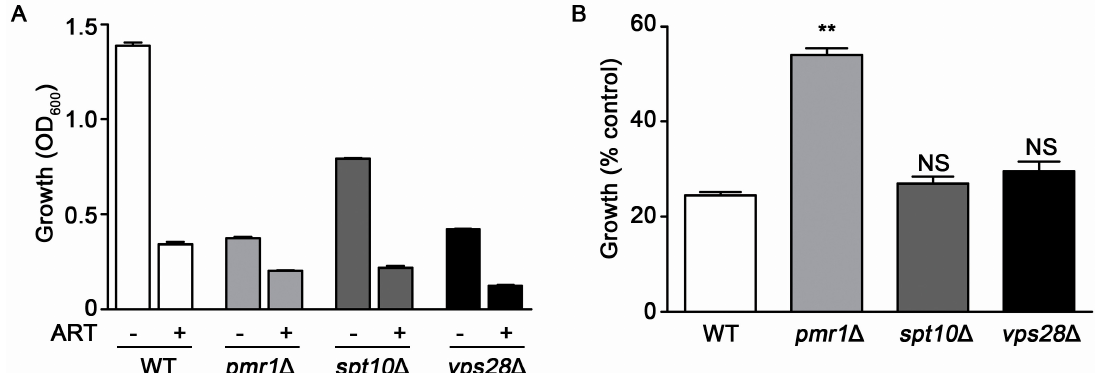
Figure 3. Slow growth is not directly associated with artemisinin sensitivity. Growth profiles for WT, pmr1 ∆ , spt10 ∆ , and vps28 ∆ cells in SCG medium monitored at 24 h after treatment with vehicle or 10 µ M artemisinin. ( A ) OD600 nm values and ( B ) percent growth compared to untreated controls for each strain. Results are from two independent experiments; values are the mean + SD with differences between WT and mutant strains analyzed using two-tailed unpaired Student’s t -test; ** P < 0.01.